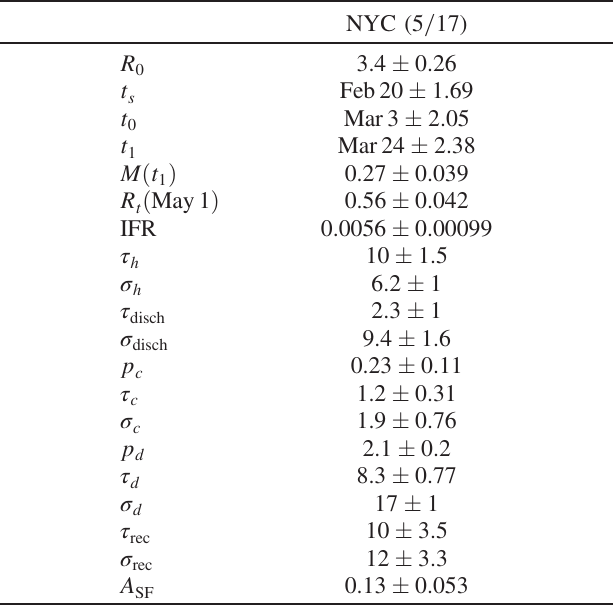
TABLE IV. Same as Table III, but for fits for New York